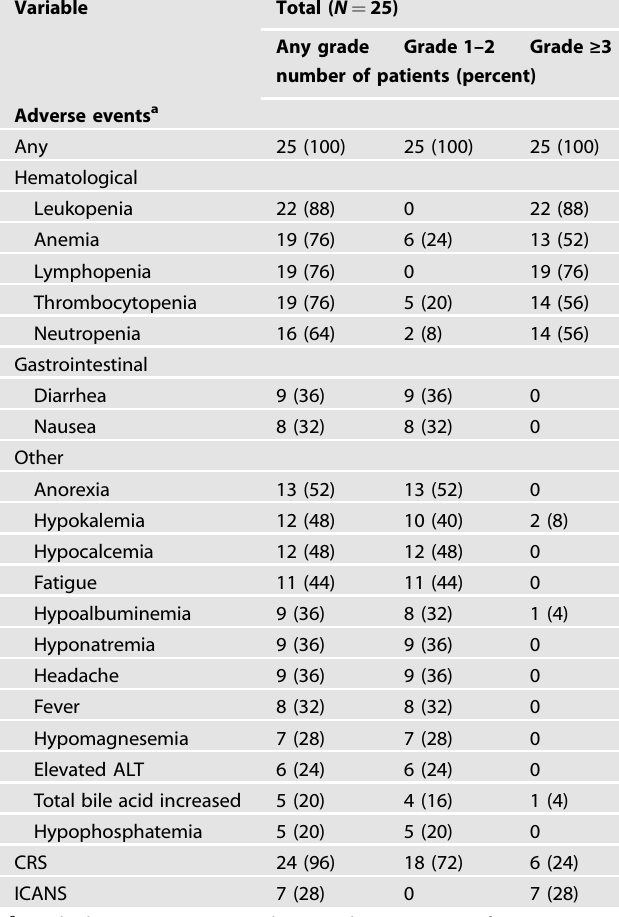
Table 2. Adverse events, CRS, and